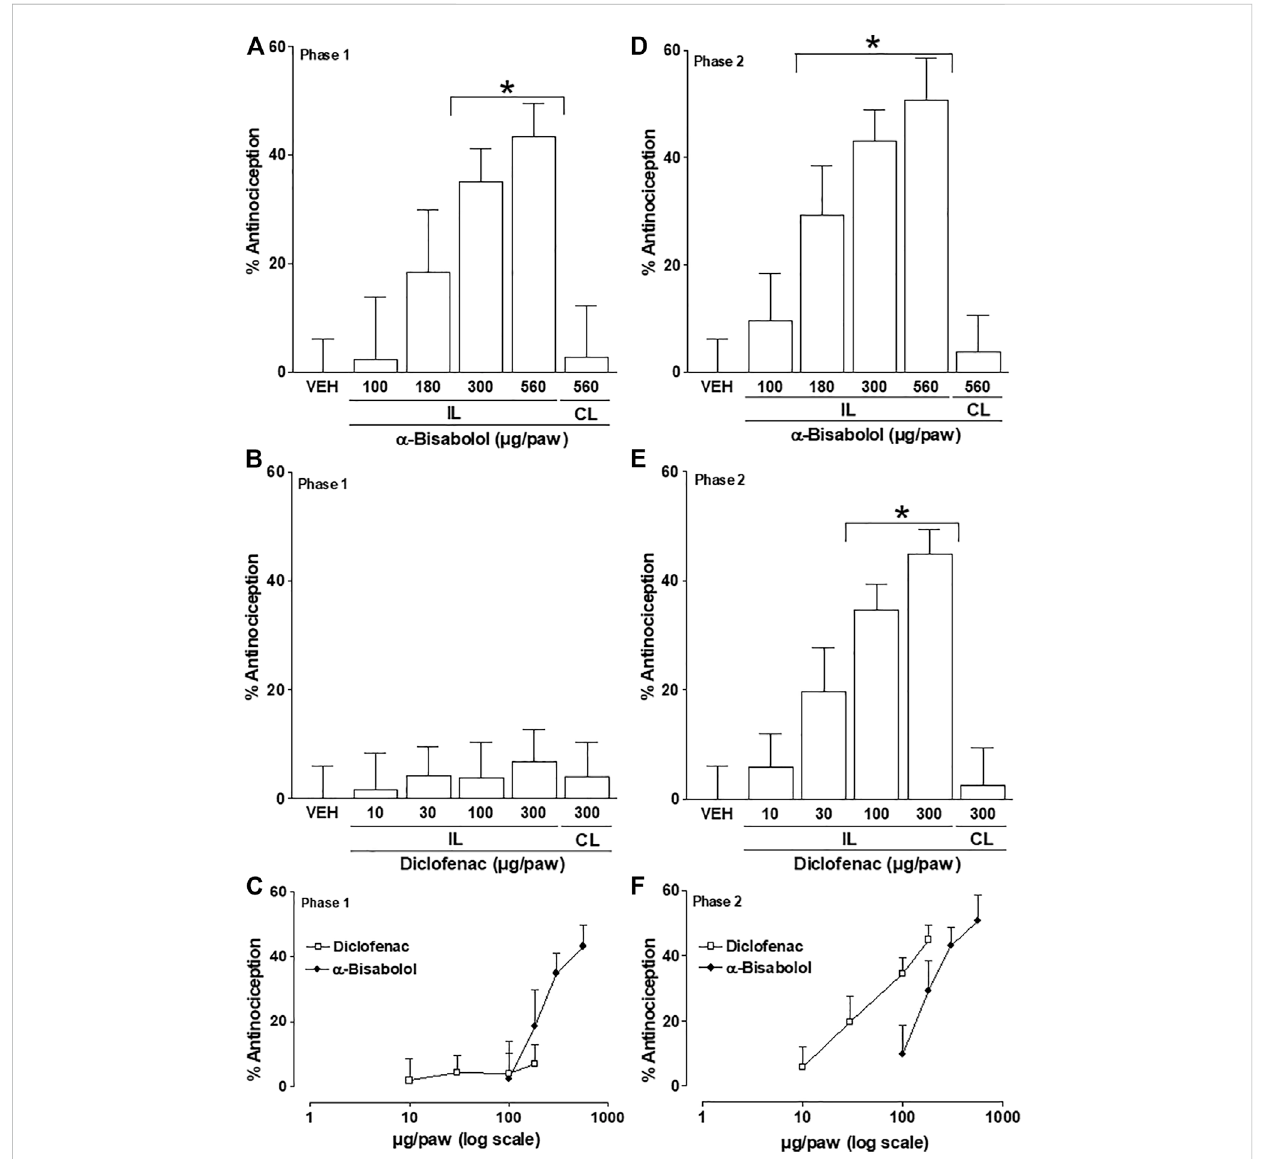
FIGURE 1 Local peripheral antinociception of α -Bisabolol and diclofenac on both phases of the 1% rat formalin test. Earlier to the injection of formalin, rats were pretreated with a local peripheral injection of vehicle (VEH), α -Bisabolol or diclofenac. Results are expressed as the antinociception percent on phaseone (A – C) andphasetwo (D – F) .Results arepresented inbargraphicsin (A,B,D,E) .Datafromthepreviousresults arepresented insigmoidcurves in (C, F) (log scales). Each point corresponds to the mean ± SEM of 5-6 animals. *Signi fi cant difference from vehicle group ( p < 0.05) as determined by the analysis of variance followed by Dunnett ’ s